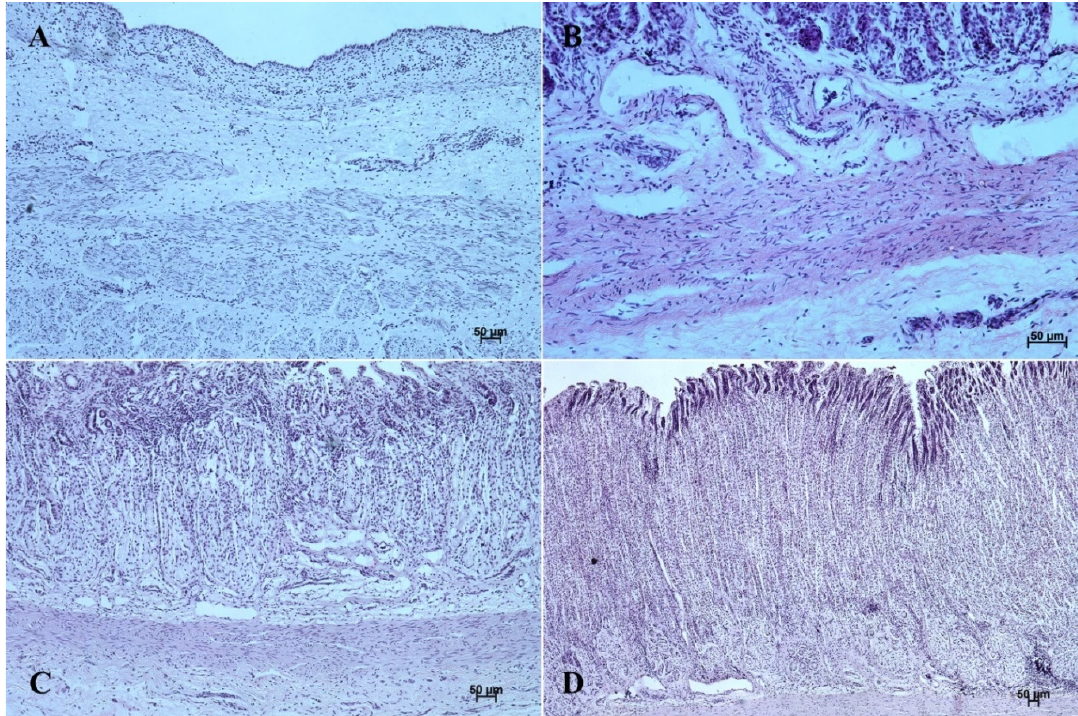
Figure 8. Histological structure of stomach mucosa in the fundic part (hematoxylin-eosin staining). ( A )—the first age group (20×); ( B )—the second age group (20×); ( C )—the third group (10×); ( D )—the reference adult group (5×).